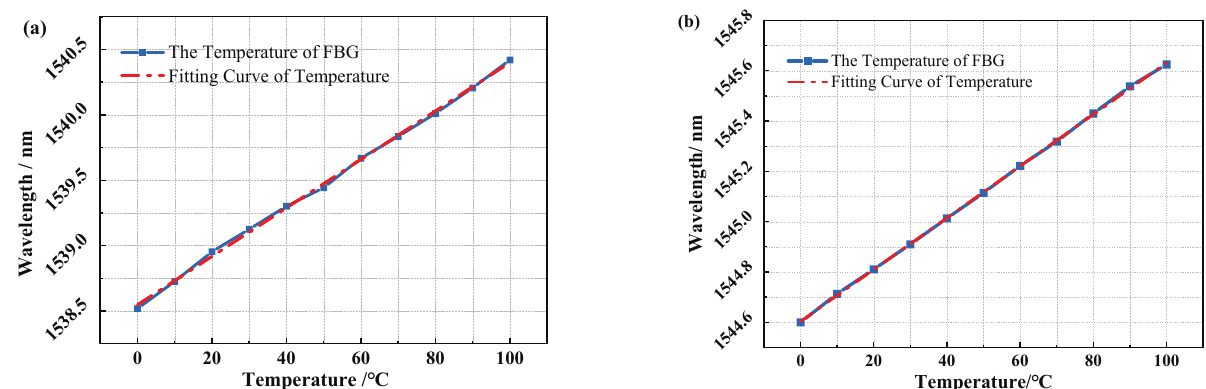
Figure 10. ( a ) Calibration curve of the air-medium FBG temperature sensor, ( b ) Calibration curve of the grease-medium FBG temperature sensor.